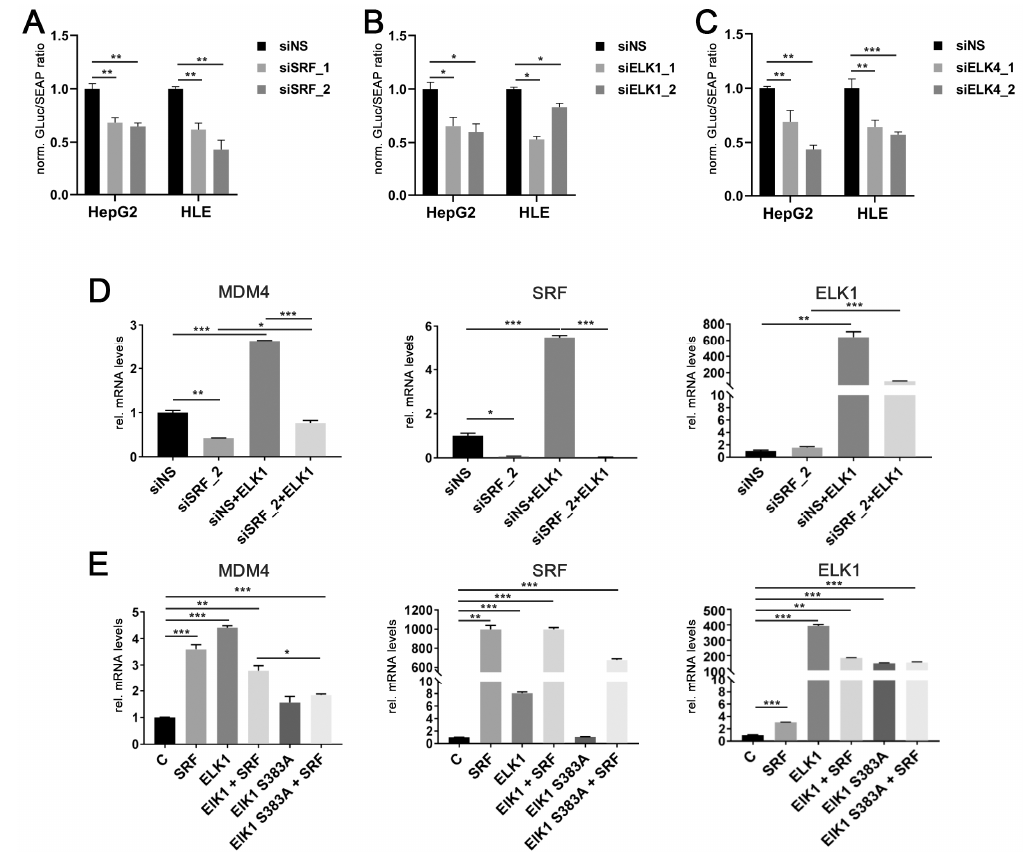
Figure 3. ELK1 and ELK4 are essential co-factors for SRF-mediated transcriptional regulation of MDM4 in HCC. Luciferase activity of a MDM4 promoter reporter upon siRNA-mediated knockdown of ( A ) SRF, ( B ) ELK1, and ( C ) ELK4 in HepG2 and HLE cells compared to controls. ( D ) MDM4 mRNA levels after co-transfection of an ELK1 cDNA with siNS or siSRF. Transfection efficacy was confirmed by detection of ELK1 and SRF mRNA levels. ( E ) MDM4 mRNA levels following transfection of the indicated cDNA plasmids. ELK1 S383A represents an inactive variant, which cannot be activated by phosphorylation of S383 and is thus unable to initiate target gene transcription. Transfection efficacy was confirmed by detection of ELK1 and SRF mRNA levels. Data are presented as mean ± SEM. Mann-Whitney U test: * p < 0.05, ** p < 0.01,